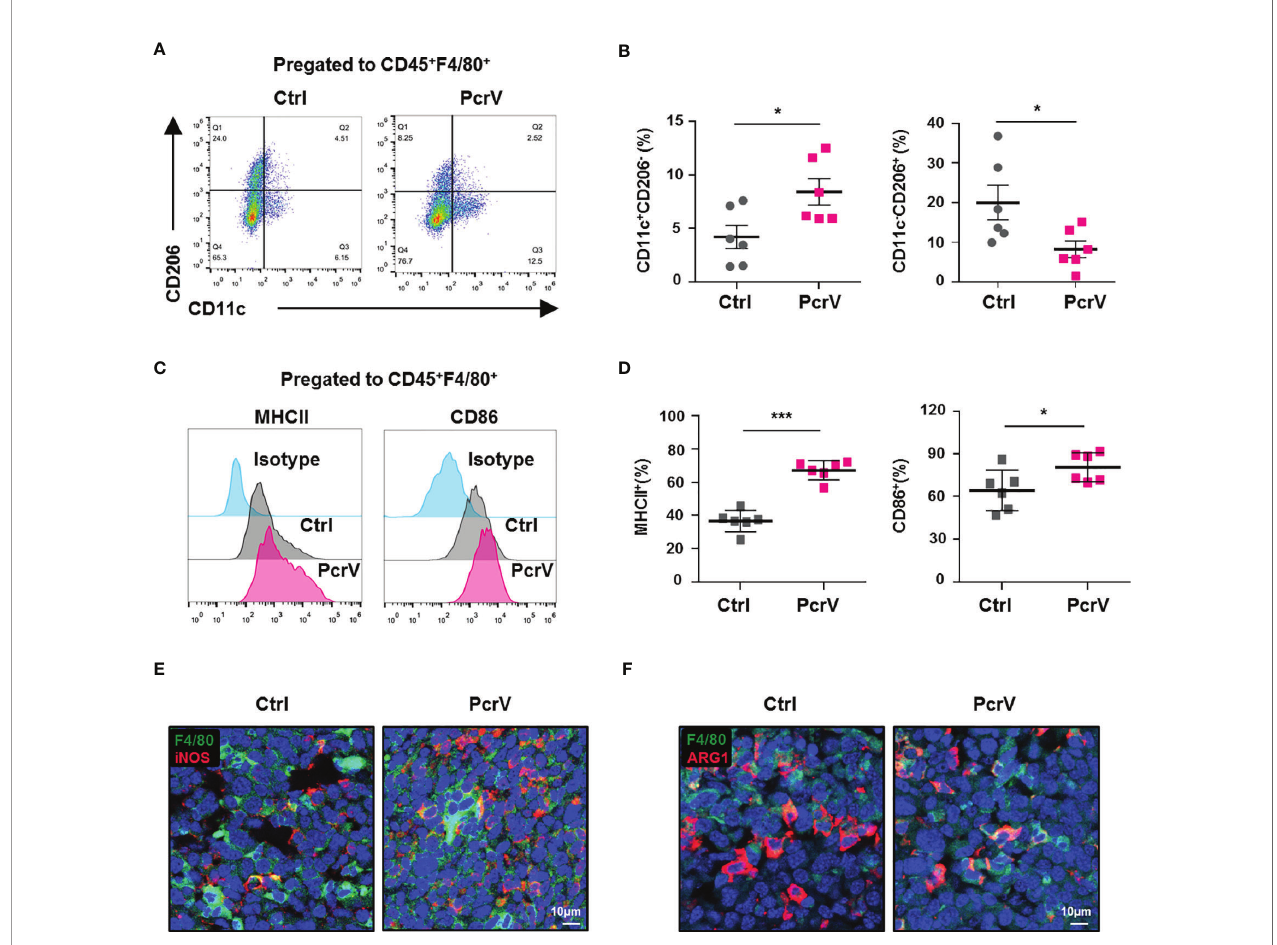
FIGURE 2 | PcrV reeducates tumor-associated macrophages (TAMs) into a tumoricidal M1 phenotype in vivo . Mice bearing LLC cell-derived tumors were treated with PBS or PcrV. (A – D) FACS analysis of the percentages of M1 (CD45 + F4/80 + CD11c + CD206 − , CD45 + F4/80 + MHCII + , and CD45 + F4/80 + CD86 + ) and M2 (CD45 + F4/80 + CD11c − CD206 + ) TAMs in tumor tissues. (E, F) Immuno fl uorescence staining for visualizing F4/80 + iNOS + M1 and F4/80 + Arg1 + M2 TAMs in tumor tissues. Data were expressed as means ± SD [ (B, D) , n = 6] and analyzed by unpaired Student ’ s t -test. * p < 0.05 and *** p < 0.001. Ctrl indicates control. LLC, Lewis lung cancer; PBS, phosphate-buffered saline; FACS, fl uorescence-activated cell